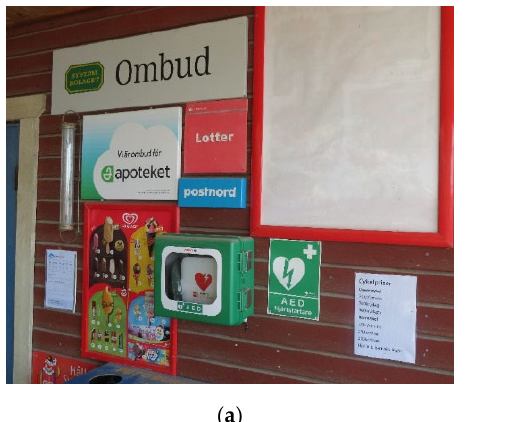
Table 1. Signs of the linguistic landscapes categorized by location and function. Categories 1–4 cor ‐ respond to different types of text assemblage points while categories 5–6 include items found throughout the linguistic landscapes.